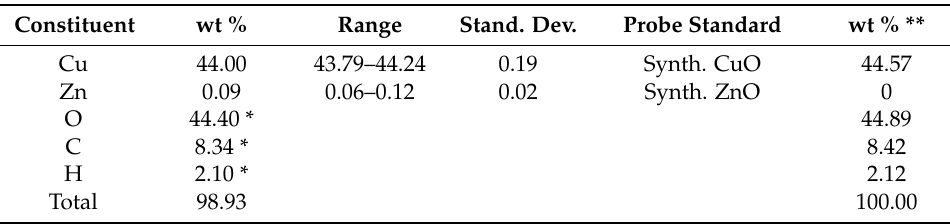
Table 1. Chemical data for fiemmeite.